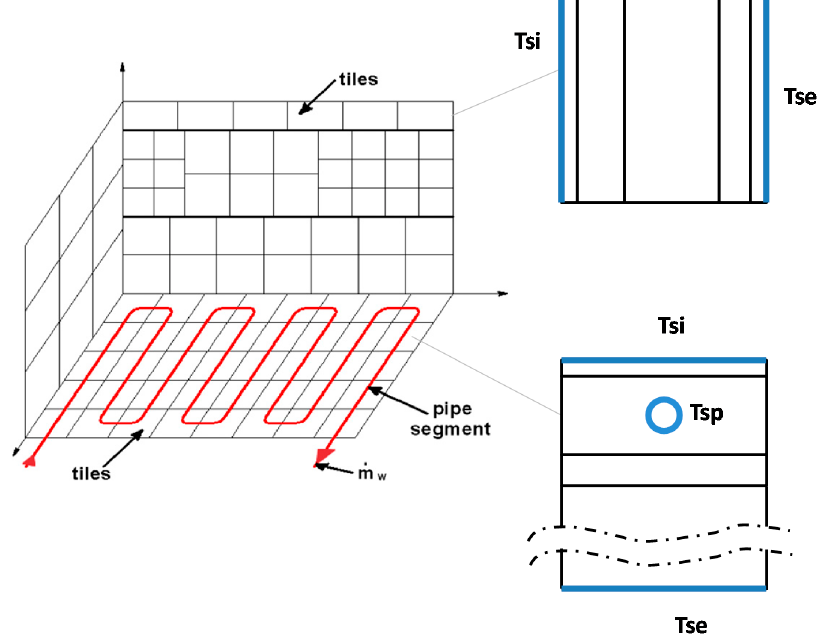
Figure 1. Example of discretization of a room equipped with a radiant system embedded in the floor [24] with the relevant surfaces where the heat balance is solved for structures with or without embedded pipes.